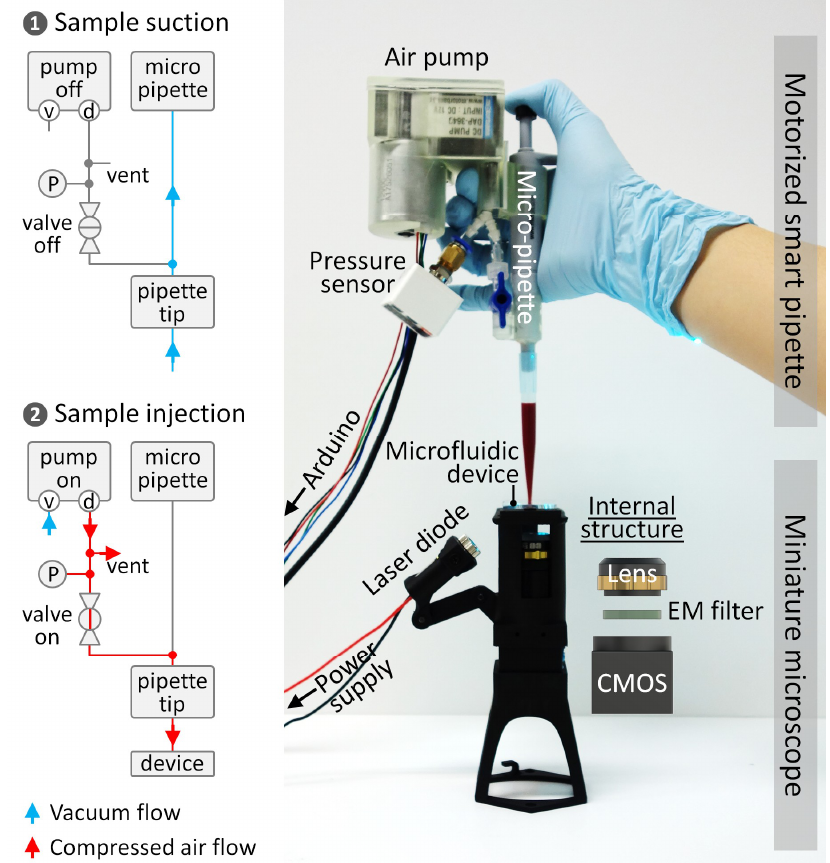
Figure 1. Handheld microflow cytometer composed of a motorized smart pipette for volume metering and pressure control, a microfluidic cell concentrator for target cell enrichment, and a miniaturized fluorescence microscope for imaging flow cytometric analysis. The schematics show the pneumatic control diagrams for smart pipetting. The symbols v, d, and P denote the vacuum and discharging ports of the air pump and a pressure sensor, respectively.